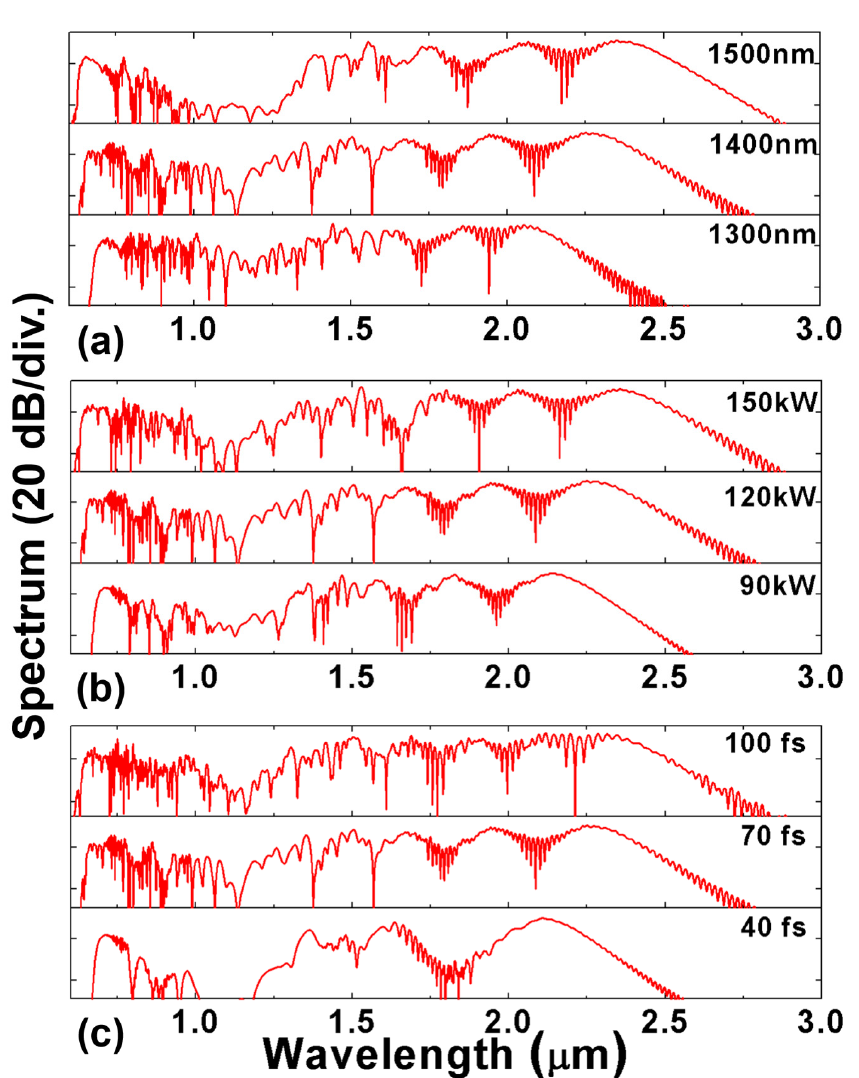
Figure 6. Influence of the initial pulse parameters on SC generation of OAM 1,1 after a 12 cm designed Ge-doped RCF for different ( a ) λ 0 ( P 0 = 120 kW, T FWHM = 70 fs); ( b ) P 0 ( λ 0 = 1400 nm, T FWHM = 70 fs); ( c ) T FWHM ( λ 0 = 1400 nm, P 0 = 120 kW).